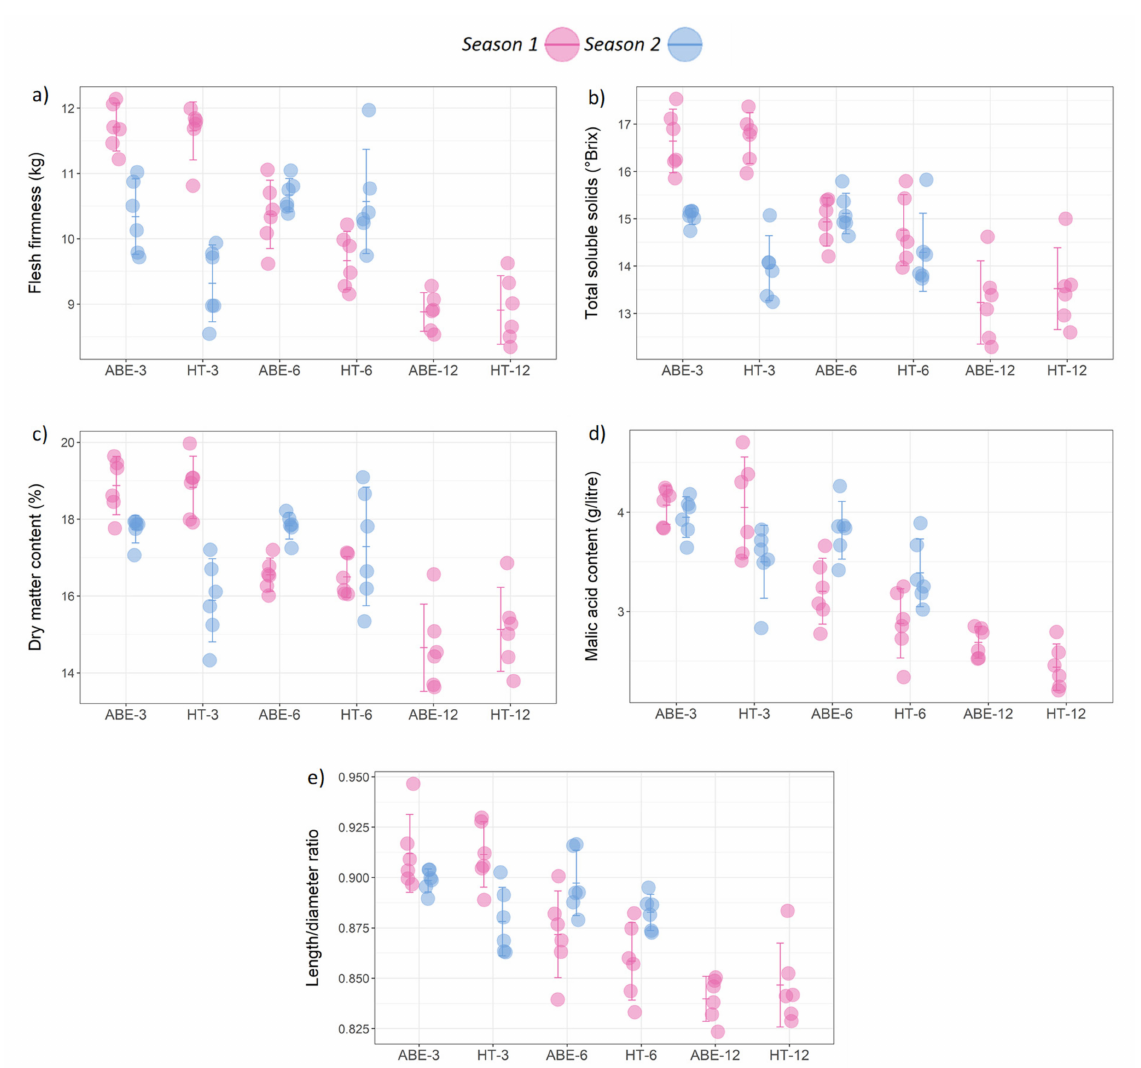
Figure 6. Effect of thinning regime and crop load on fruit quality parameters: ( a ) flesh firmness, ( b ) total soluble solids, ( c ) dry matter content, ( d ) malic acid content, and ( e ) length/diameter ratio under different treatments across two seasons (error bars represent 95% confidence interval). ABE = artificial bud extinction; HT = hand